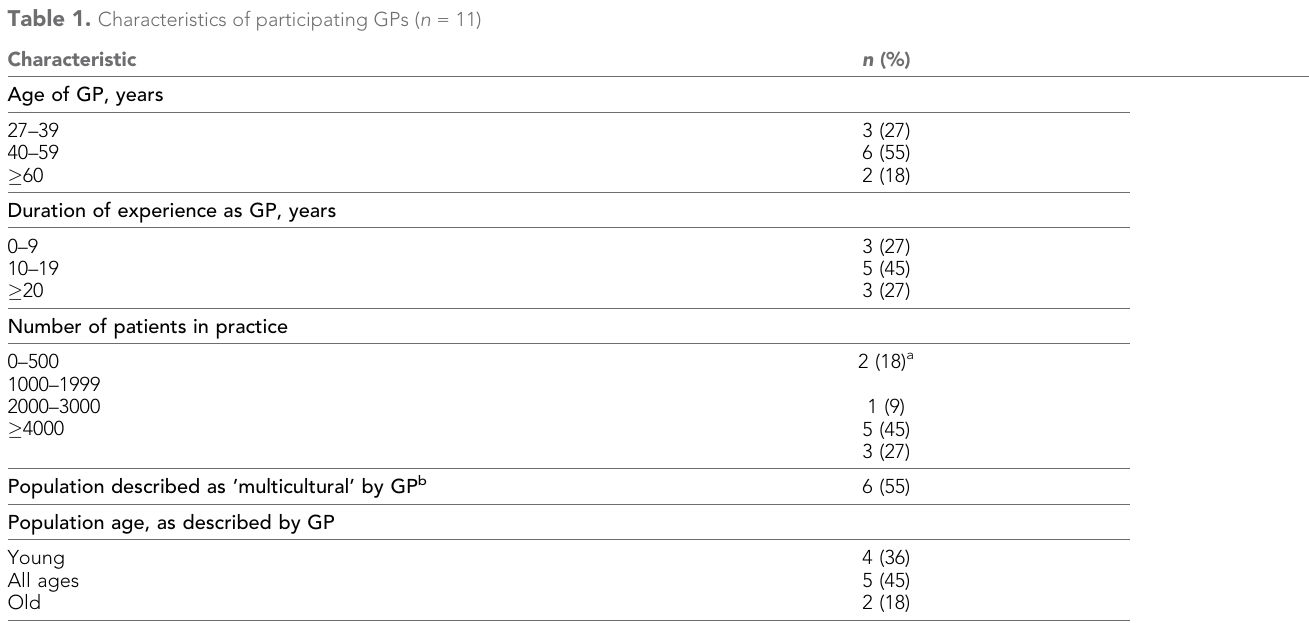
Table 1. Characteristics of participating GPs ( n = 11)